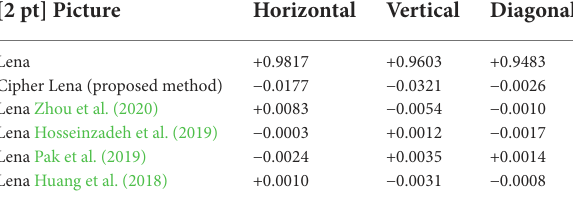
TABLE 1 Adjacent pixels correlation